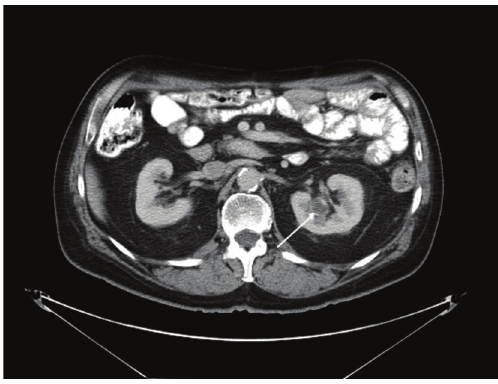
Figure 1: CT scan of the abdomen showing a 2.2 cm solid lesion in the midpole of the left kidney near the pelvis (white arrow).